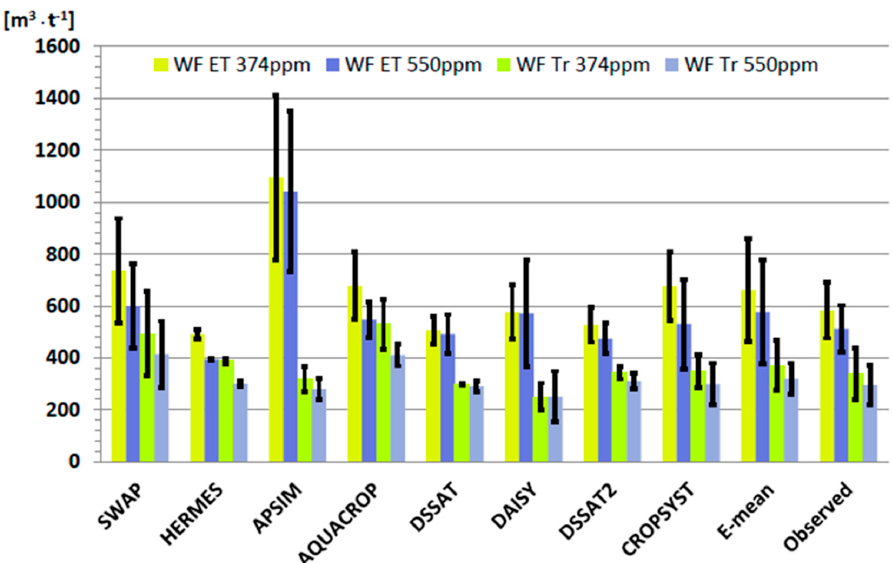
Figure 7. Water footprints of winter wheat calculated from simulations of different models for ambient (374 ppm) and elevated (550 ppm) CO 2 concentrations of the FACE experiment at Braunschweig/Germany. Error bars of the model results and observations show inter ‐ annual variability, error bars of the ensemble mean the inter ‐ model variability. “Observed” is calculated from simulated ET and Tr and observed yields.